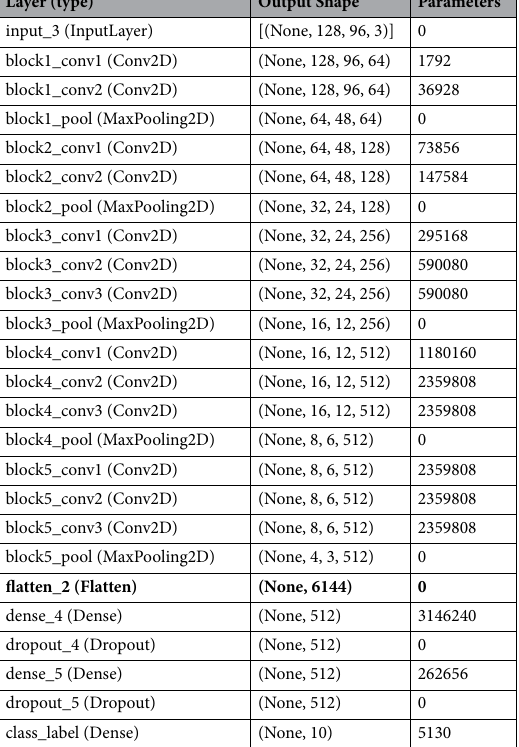
Table 1. Architecture of the VGG16 model; Total parameters: 18,128,714, trainable parameters: 3,414,026 ; non-trainable parameters: 14,714,688; the junction between the convolution-max pooling layers of the original VGG16 model and the fully connected layers attached to its output – is shown in bold. The final output layer produces 10 numbers, corresponding to the probabilities of a given image belonging to the 10 classes of tissue.